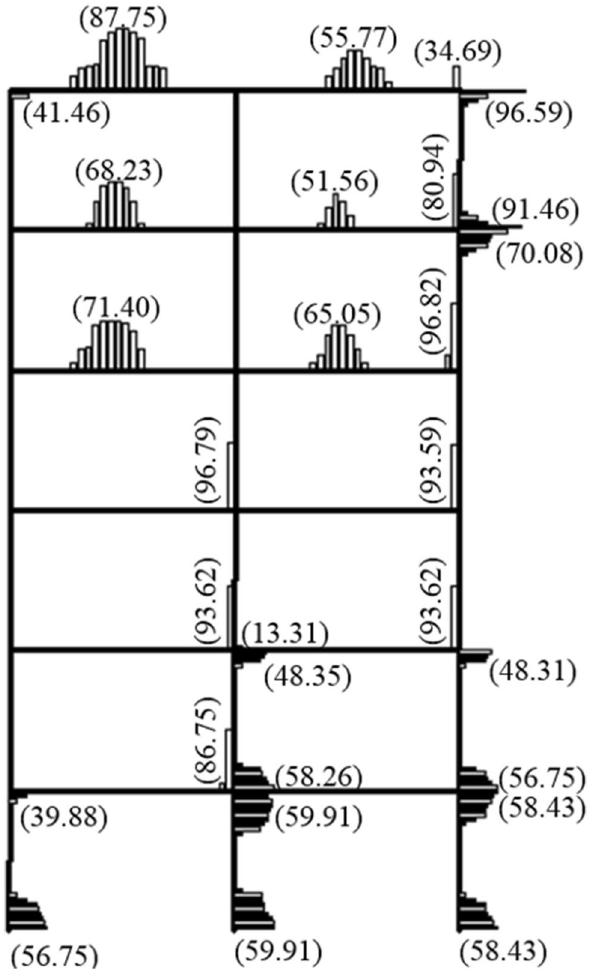
Fig. 24 Plasticity of six-story frame at limit load